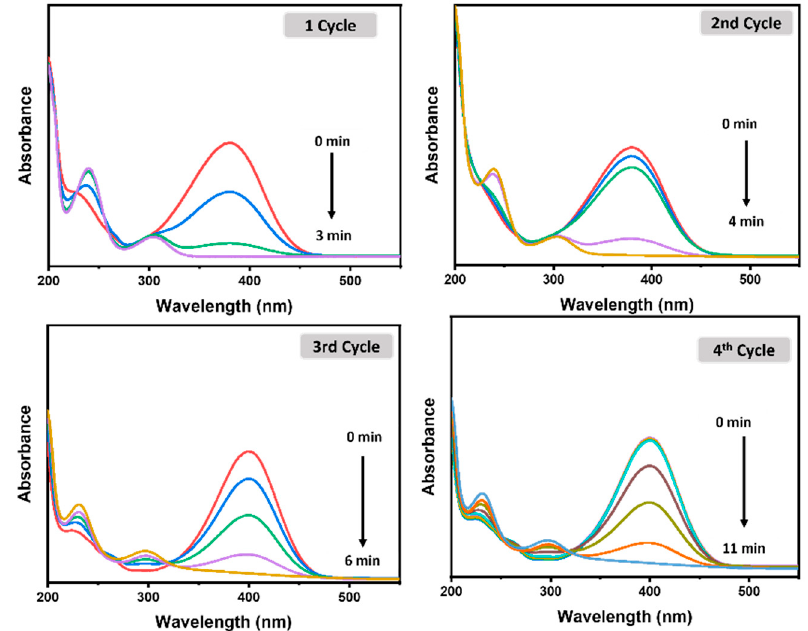
Figure 10. UV–Vis spectra for recyclability of CMC/CuO-TiO 2 beads toward the catalytic reduction of 0.13 mM 4-NP. Table 2. Application of CMC/CuO-TiO 2 nanocatalyst beads on four types of real samples spiked with